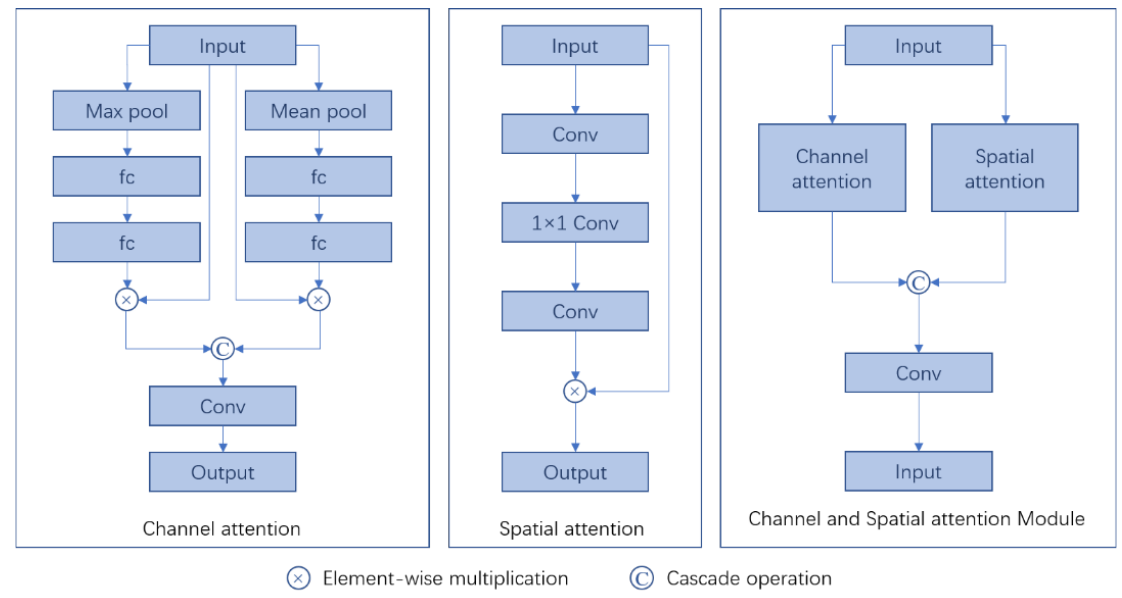
Figure 2. The CSAM schematic.